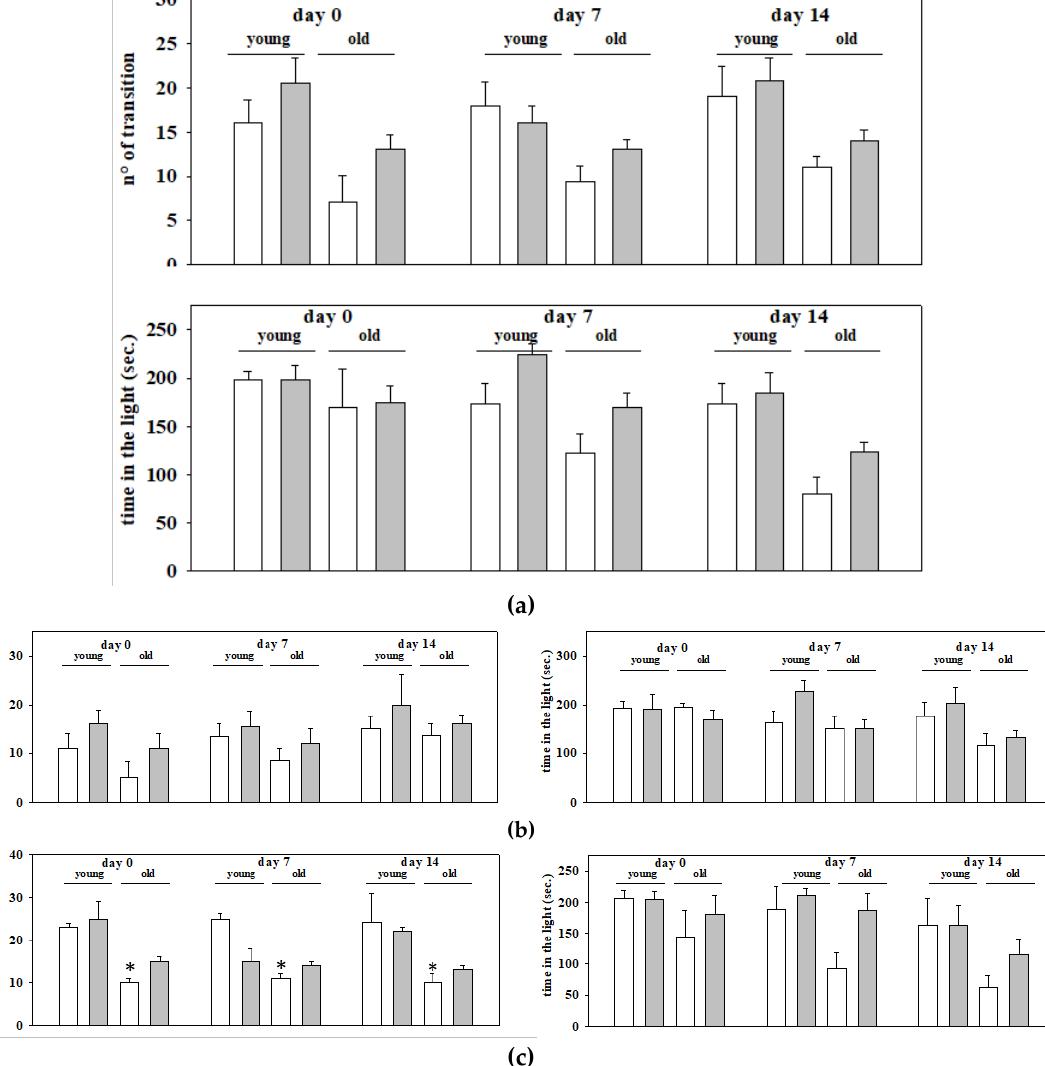
Figure 2. Motor and anxiety behavior in young and old mice: effects of chronic EAm treatment. EAm-untreated (empty bar) or EAm-treated (gray bar) young and old mice were analyzed for explorative and anxiety-related behavior in the light dark box. Behavioral skills were quantified as number of transitions between the two sides of the maze (n° transitions), as well as the total time spent in the light compartment of the light dark box (time in the light), before (Day 0), during (day 7) and at the end (day14) of the EAm administration. ( a ) Data represent the mean ± S.E.M. of 35 animals (17 young mice and 18 old ones) analyzed in two different trials carried out on different days. ( b ) Data represent the mean ± S.E.M. of the 17 animals (9 young mice and 8 old ones) analyzed in the first trial; ( c ) Data represent the mean ± S.E.M. of the 18 animals (8 young mice and 10 old ones) analyzed in the second trial. Statistical analysis was performed by applying ANOVA followed by the Tukey’s Multiple Comparison test. * p < 0.05 vs. EAm-untreated young mice.